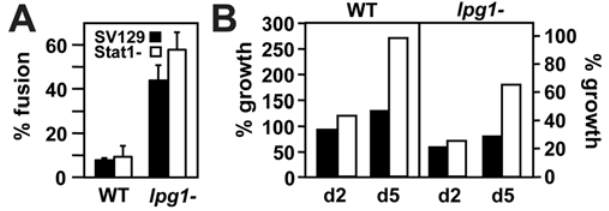
Figure 7. Phago-lysosomal fusion does not affect Leishmania major survival. (A) Phago-lysosomal fusion was quantified by labeling of parasitophorous vacuoles with FITC-dextran, previously loaded into the lysosomal compartment (Methods). (B) PEM infection was performed as described in legend of Figure 1B. Experiment was done in duplicate and mean values are